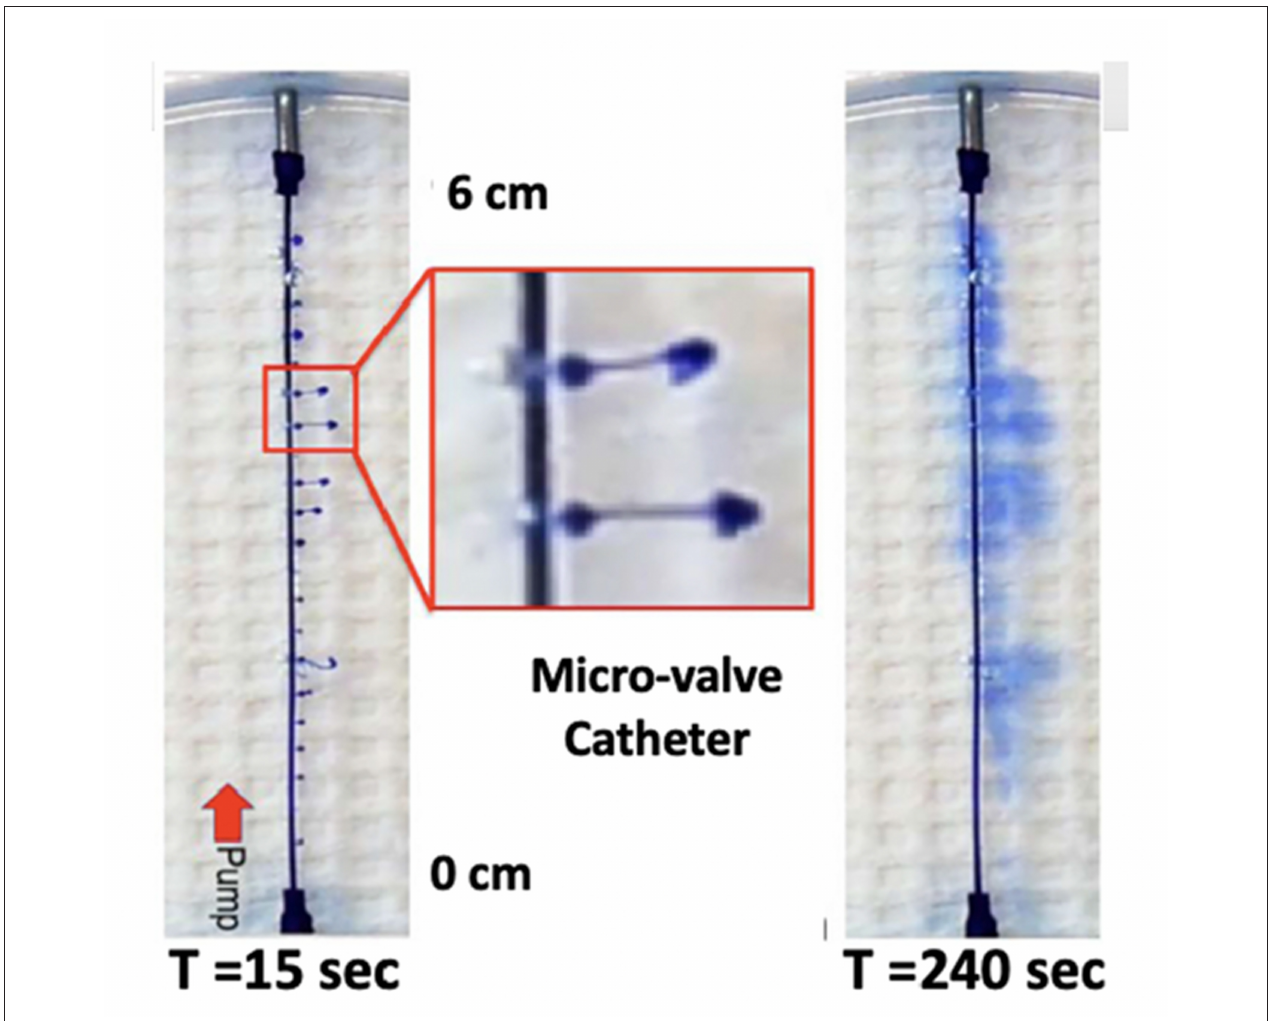
FIGURE 9 | Two-dimensional diffusion chamber with a catheter having 20 microports. Images taken at 15s (top, left) and 240s (bottom, left), following bolus delivery of 2.6 µ l as a bolus at time 0. The image on the right of the T = 15s image shows an enlargement of the high velocity stream exiting the catheter at two of the exit valves, with the characteristic mushroom head where dye laden solute encounters the local dye-free fluid phase. Note the even distribution of dye from proximal (pump) to distal over the 6-cm catheter distance (T. L. Yaksh).